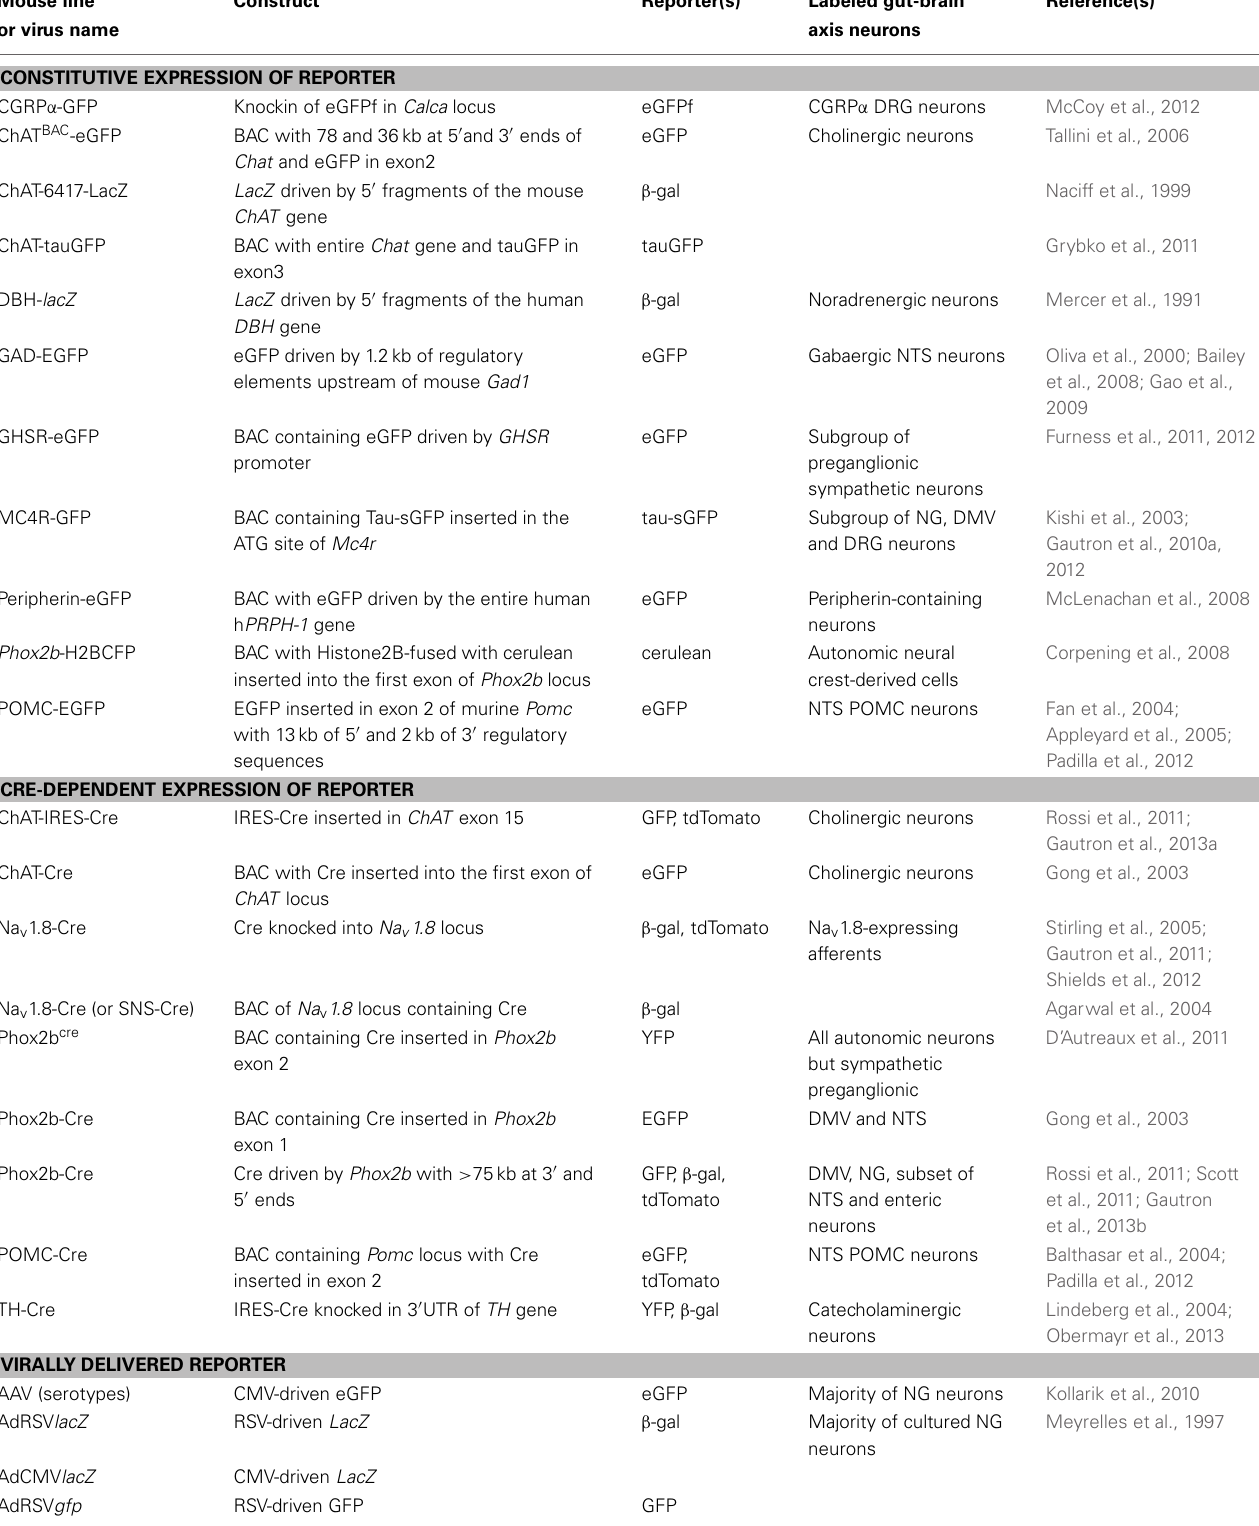
Table 1 | Non-exhaustive list of the genetic models employed to introduce reporter expression in the rodent gut-brain axis. Mouse